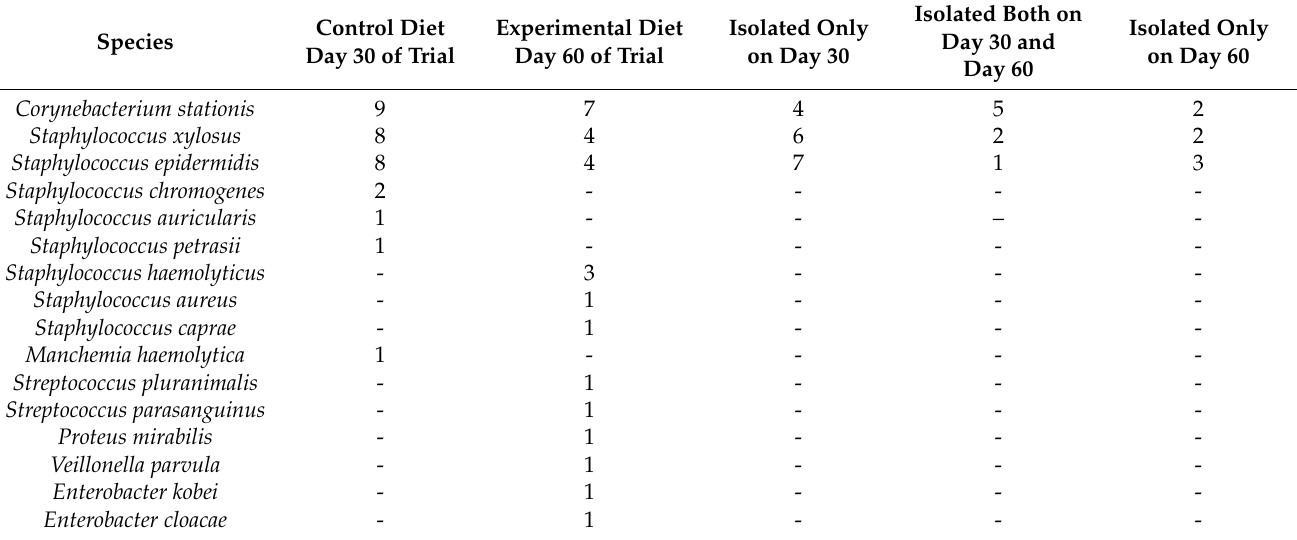
Table 5. Bacterial isolates from the milk of sheep before (control diet—day 30 of trial) and after 30 days of feeding feeds enriched in omega-3 fatty acids (experimental diet—day 60 of